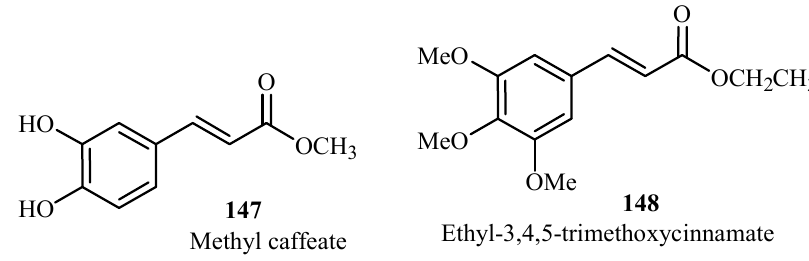
Figure 22. Cinnamic acid derivatives (CADs) reviewed by Sharma [83].